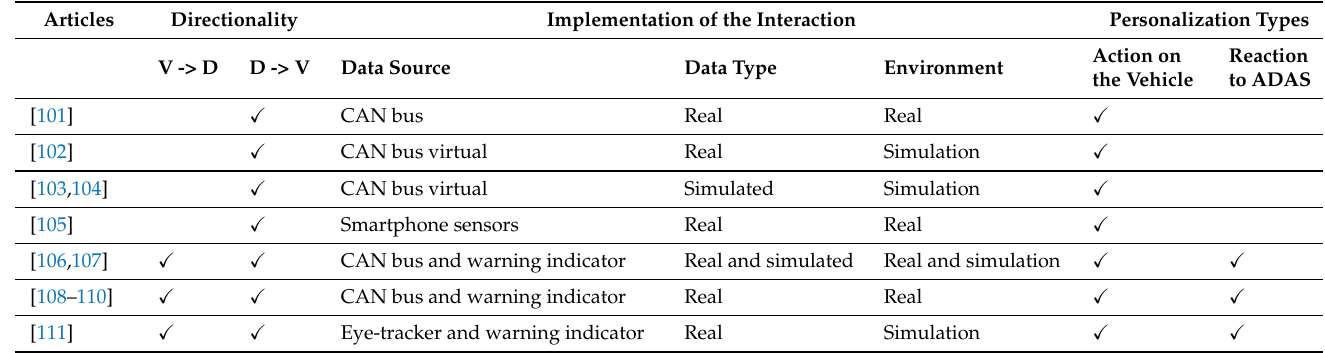
Table 4. Works in which driver–vehicle interaction is addressed. The type of personalization described in the consulted works is analyzed from two approaches: (i) the action that the driver exerts on the driving elements of the vehicle (described as an action on the vehicle) and (ii) the reaction that the driver adopts before the notices and alerts sent by the system (described as reaction to